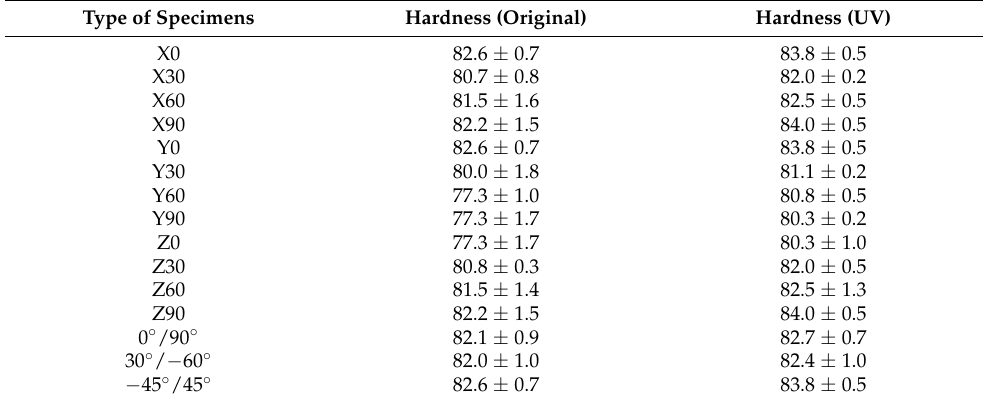
Table 4. The hardness (Shore D) measurement results on the flat surface.